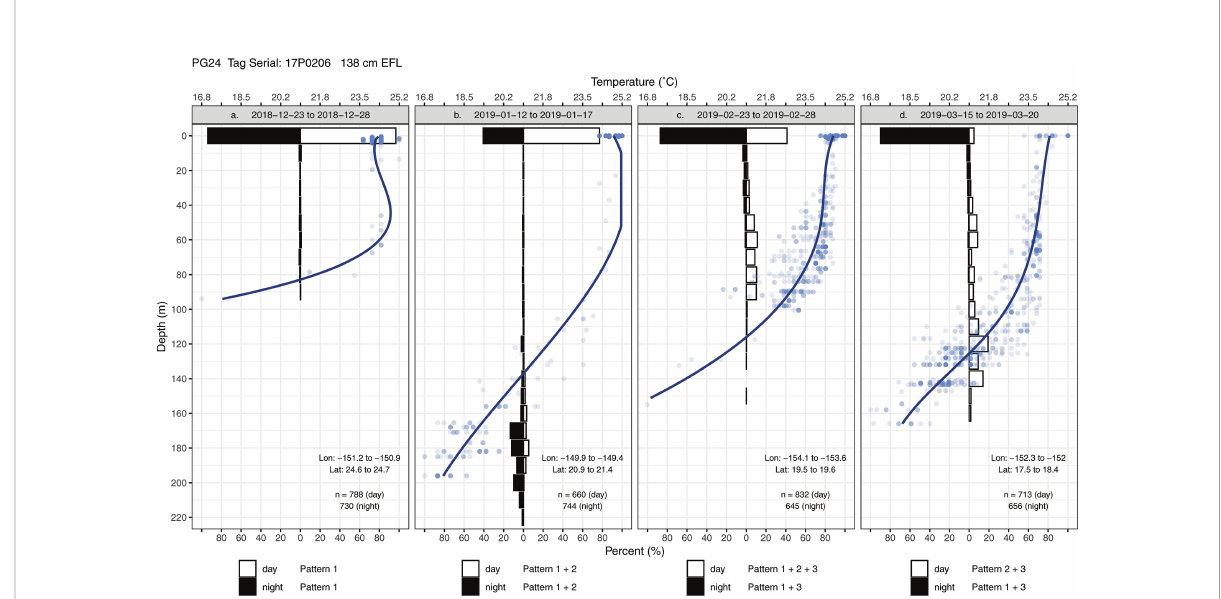
FIGURE 5 Diel time-at-depth histograms and daytime depth-temperature pro fi les of striped marlin PG24 from (A) 2018-12-23 to 2018-12-28, (B) 2019- 01-12 to 2019-01-17, (C) 2019-02-23 to 2019-02-28, and (D) 2019-03-15 to 2019-03-20. In the histograms, depths were binned at every 10 m. Depth-temperature values (blue dots) in each period were also fi tted with a regression spline to construct a smoothed pro fi le (thick blue line). Depth patterns were identi fi ed for day and night: Pattern 1 is characterized by a fi sh staying near the sea surface for extended periods; Pattern 2 features a high occupancy of the thermocline, either through brief (sometimes repetitive) trips from the surface or oscillatory movements within the thermocline; Pattern 3 is marked by multiple trips to various depths within the mixed layer either from the surface or from the